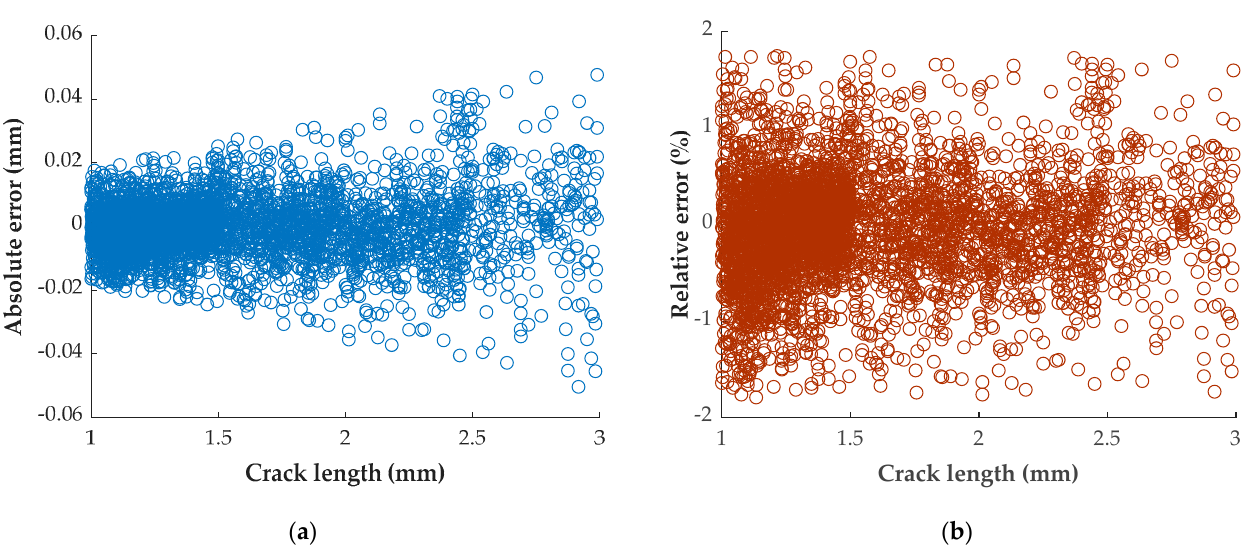
Figure 13. Errors of test examples of our result: ( a ) absolute errors; ( b ) relative errors.